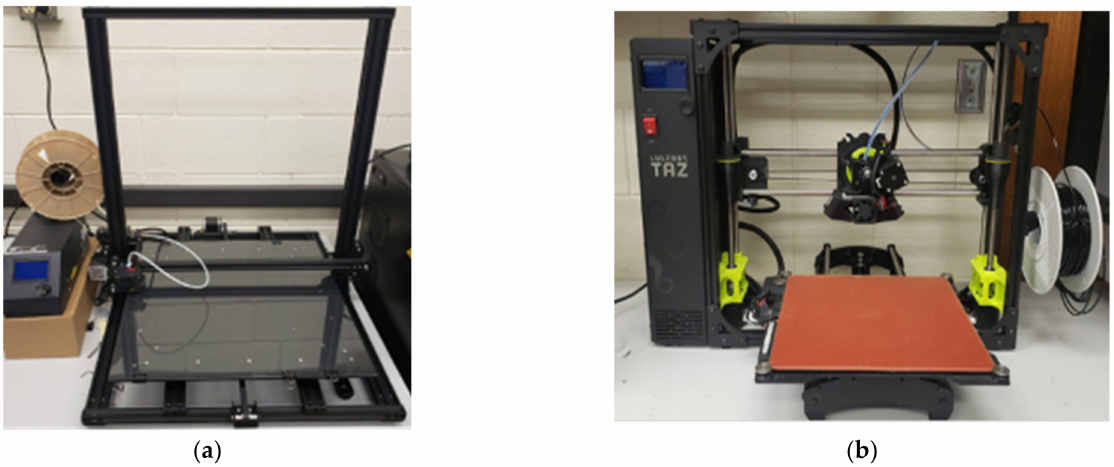
Figure 3. ( a ) A Creality 3D CR-10 DIY High Precision 3D printer used for printing conductive Electrifi trace; ( b ) a LulzBot Taz6 3D printer used for printing NinjaFlex